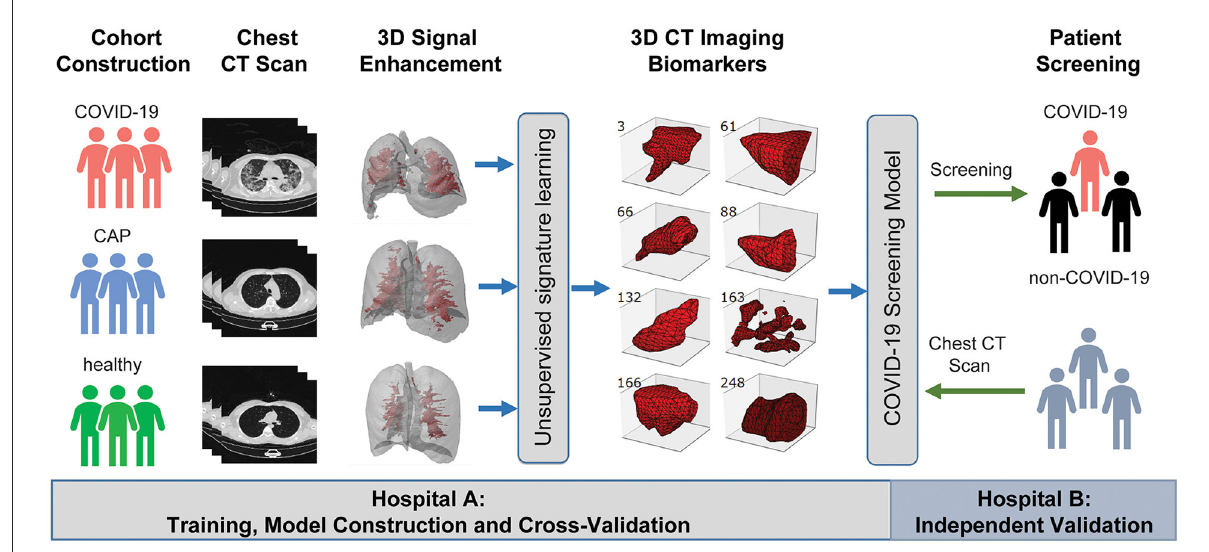
FIGURE2 A graphic illustration of the study design. A case-control study was designed to identify chest CT-based imaging biomarkers for COVID-19 patient screening. Biomarker discovery and biomarker-based predictive model construction were conducted using the data from Hospital A (training cohort), which were validated in Hospital B (validation cohort) with the double-blind